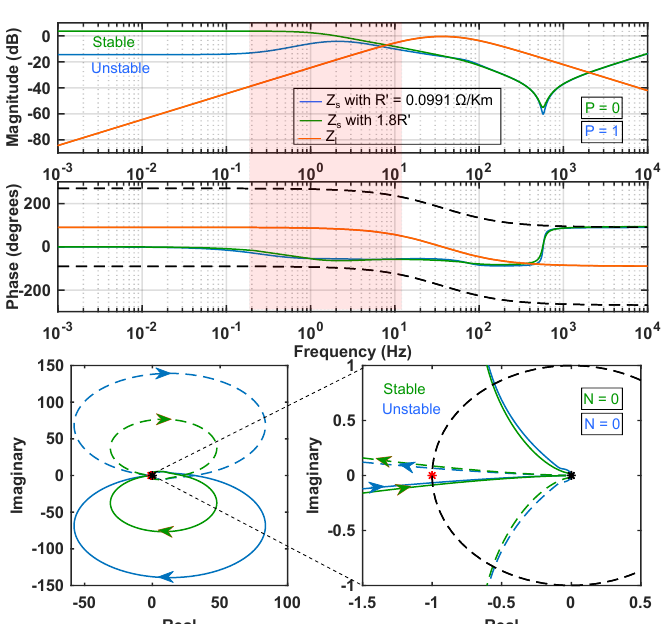
Figure 25. String with 9 WTs—Impact of cable resistance on system stability at P 3